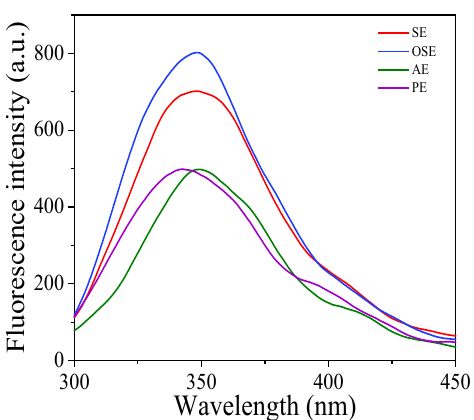
Figure 4. Intrinsic fluorescent spectrum of field muskmelon seeds protein extracted by different oil extraction methods.